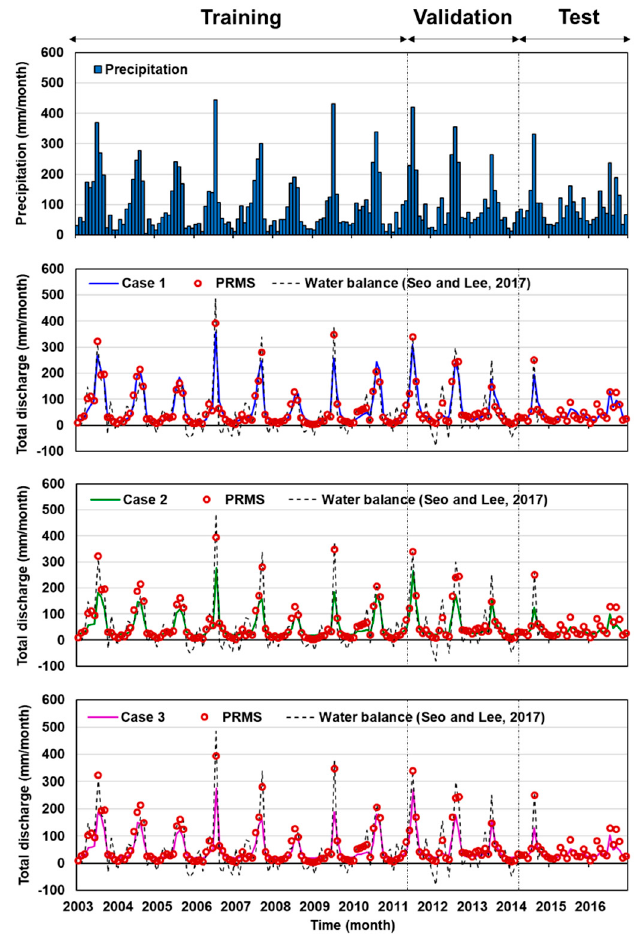
Figure 9. Total discharge results (ANN-predicted, PRMS, and water balance-based) with observed precipitation for South Korea.